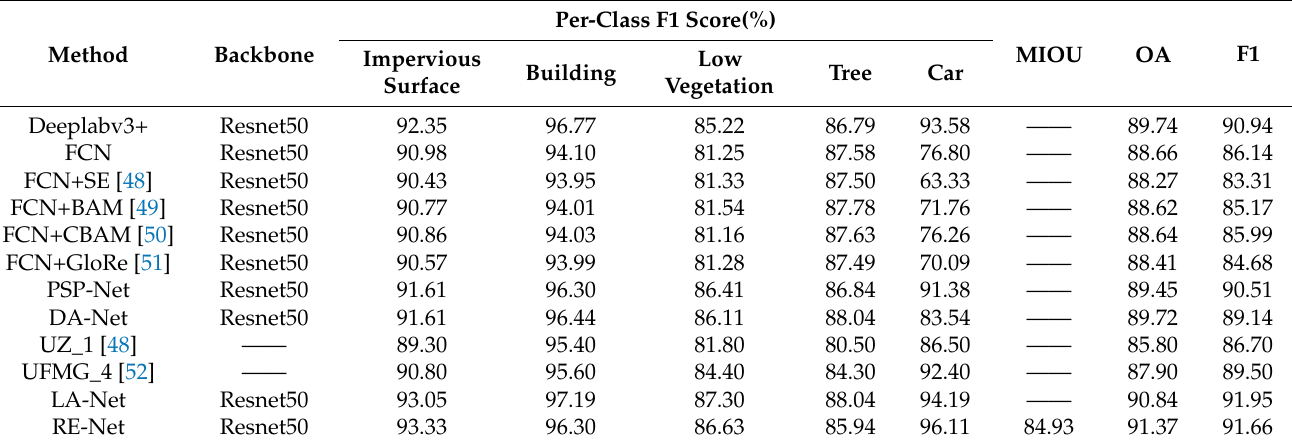
Table 5. The results of each model on the Postdam